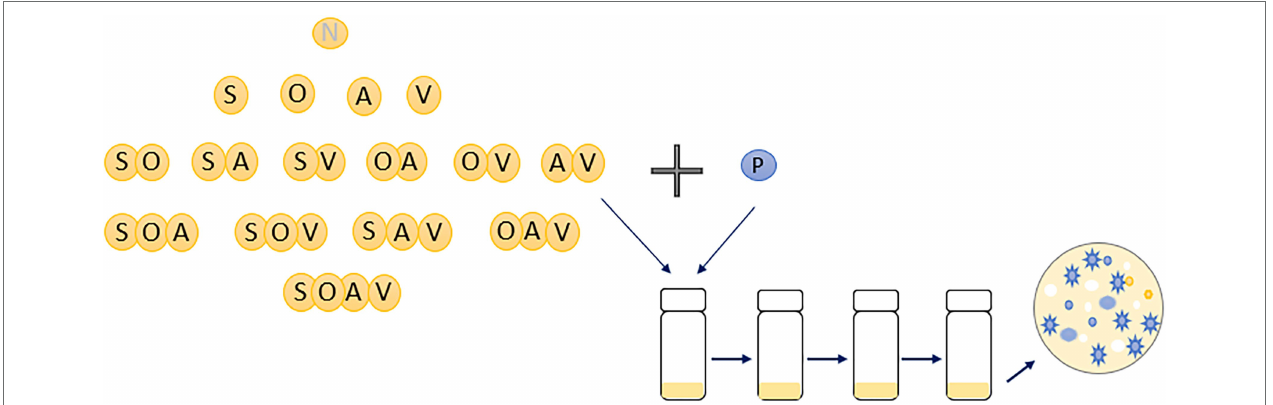
FIGURE 1 | An illustration of experimental design of the present study. Sixteen different microbial communities were set-up with species diversity ranging from 1 (monoculture of Pseudomonas fluorescens ) to 5 (with all five species). Six replicates were conducted for each community combination. N represents no other species were inoculated into the microcosms; P, A, O, S, and V represents Pseudomonas fluorescens , Achromobacter , Ochrobactrum , Stenotrophomonas and Variovorax , respectively. Diversity of the focal species, Pseudomonas fluorescens , at the end of the evolution experiment was estimated based on its morphological diversity of 100 randomly chosen colonies (blue